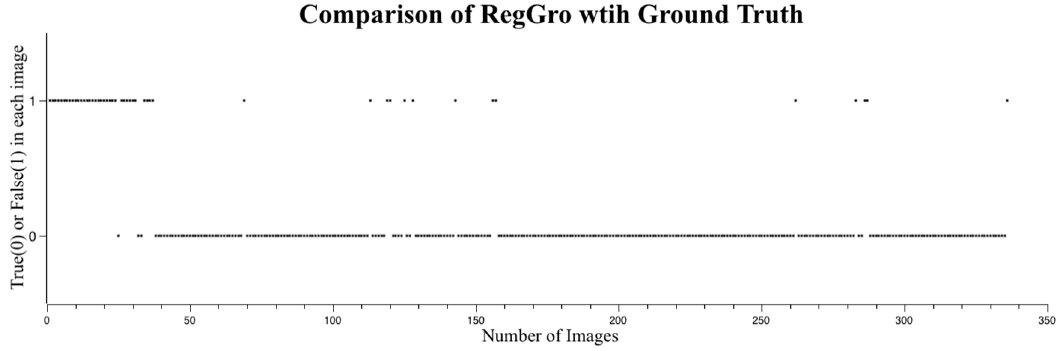
Figure 9. Segmentation success or failure with RegGro. True (0) indicates success, and False (1) indicates failure. Most false detections occurred in the first 40 images with heavy rain and fog.